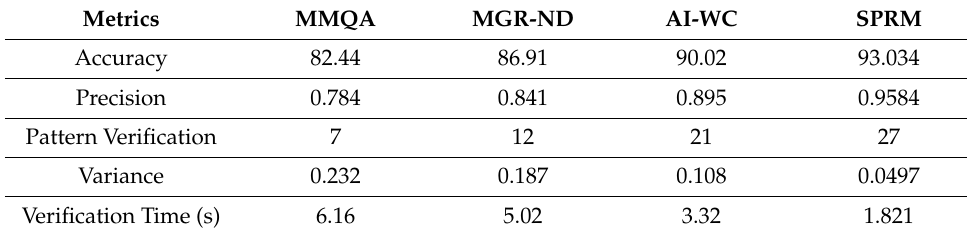
Table 1. Summary of data inputs.